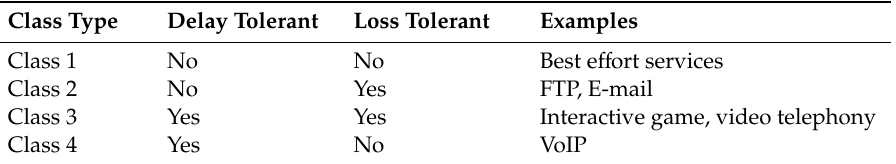
Table 1. Flow classifications. FTP: file transfer protocol; VoIP: Voice over